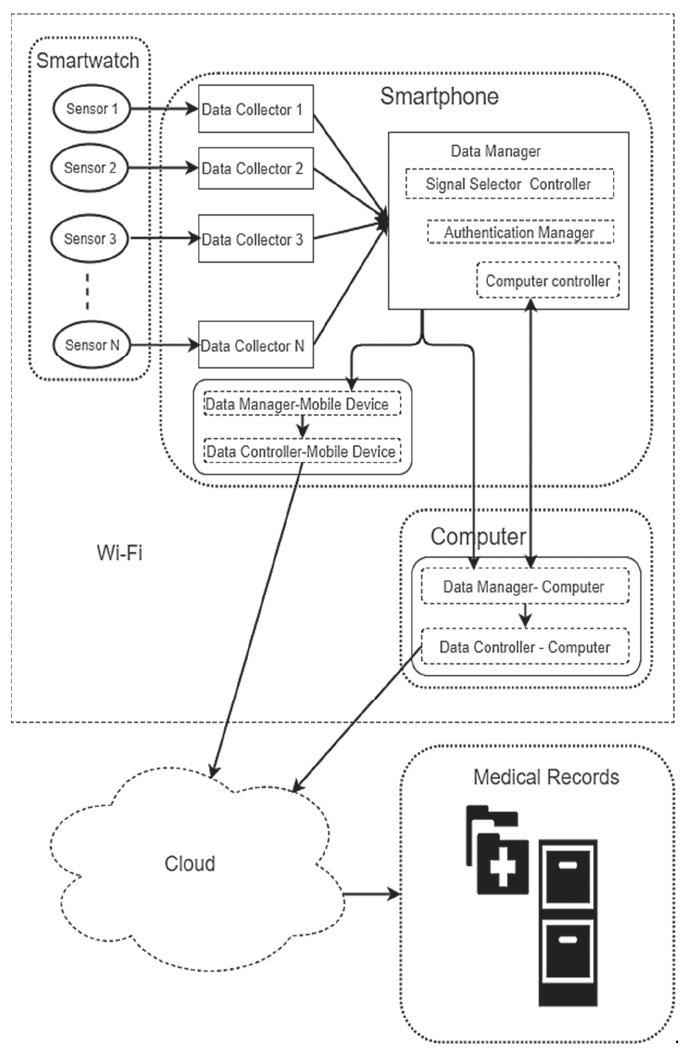
Figure 15. Showing proposed m-health data authentication framework.